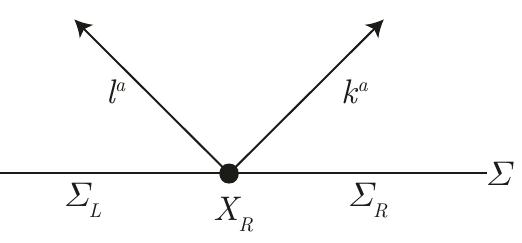
Figure 7 . A Cauchy slice (cid:6) containing the right quantum extremal surface X R . By assumption, X R splits (cid:6) into two sides, labeled (cid:6) R and (cid:6) L . (cid:6) R is a Cauchy slice of the entanglement wedge of the right side, while (cid:6) R is not necessarily a Cauchy slice of the left entanglement wedge. The null vectors ‘ a and k a are normal to X R . While this cartoon is two-dimensional, this setup is not restricted to any particular number of